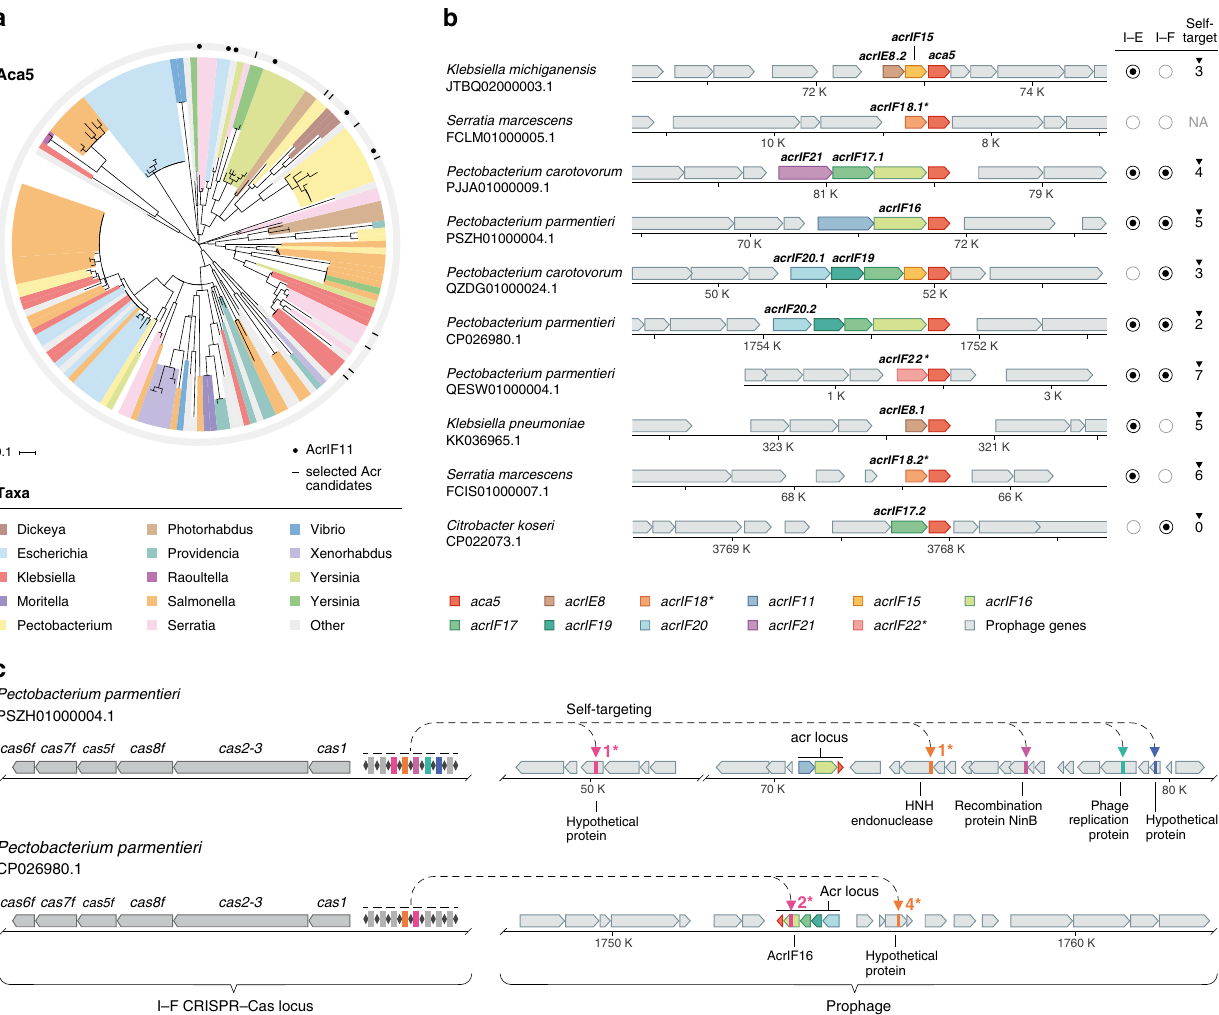
Fig. 1 Bioinformatic search of aca5 -associated acrs . a Phylogenetic distribution of Aca5 homologs across bacterial taxa. Tree branches are color-coded according to the genus from which the Aca5 orthologs originate. Black circles in the outer ring depict instances where Aca5 is associated with AcrIF11, marking the starting points for the guilt-by-association search; black lines represent the genomes from which acr candidates were selected for functional testing. b Genomic organization of the acrs selected for testing. Genes are colored by Acr family and the surrounding prophage genomic contexts are depicted in gray. Speci fi c orthologs selected for testing are highlighted in bold. The presence/absence of I – F and I – E CRISPR – Cas systems and self-targeting spacers in the host genomes are summarized on the right (for details, see Supplementary Data 1 and 2). Self-targeting analysis was not possible